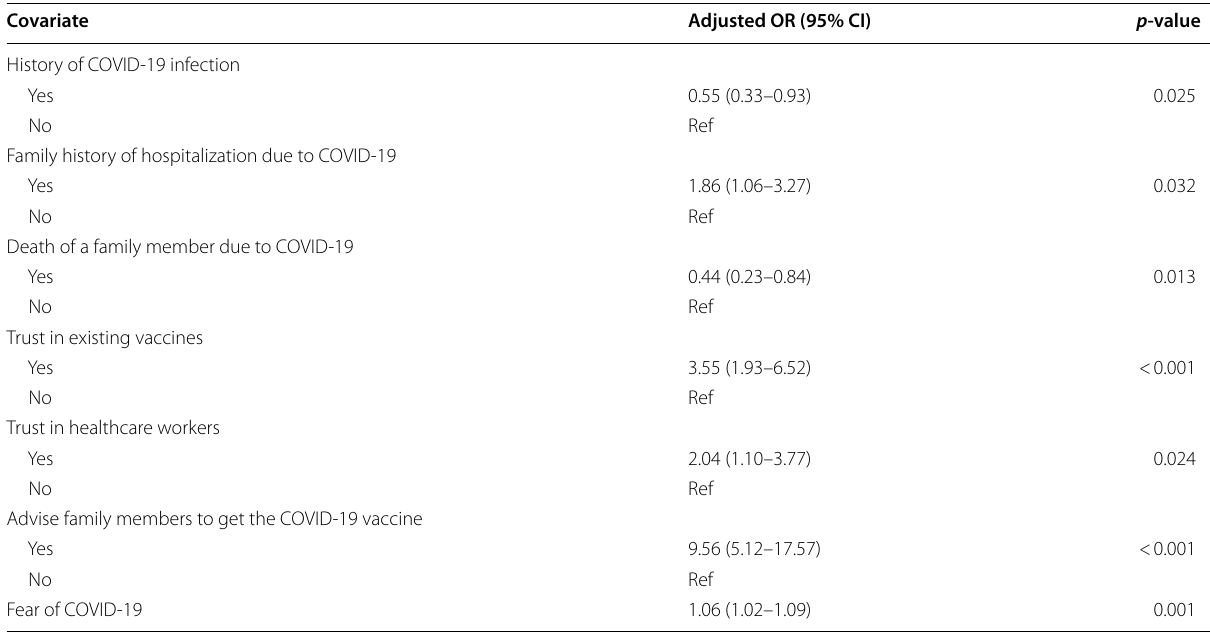
Table 3 Results from the stepwise logistic regression modeling by backward elimination method with likelihood ratio method using all covariates ( N =